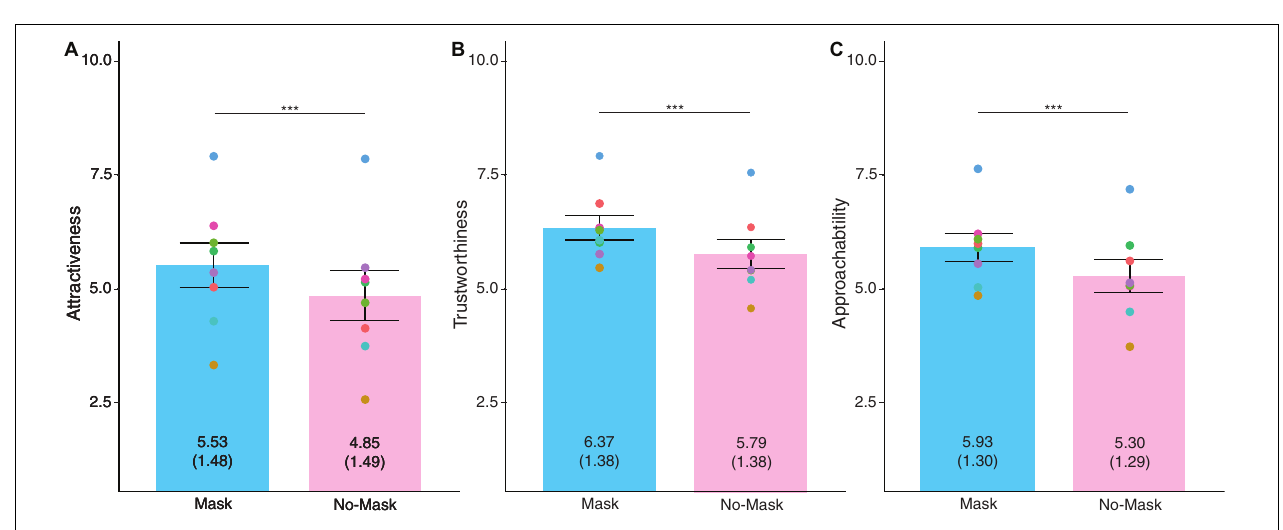
FIGURE 3 | Ratings for trait-like characteristics of (A) Attractiveness, (B) Trustworthiness, and (C) Approachability. Individual points represent averaged rating for each face. The values depicted in each bar are the mean ratings and the standard deviation is in parenthesis. Error bars indicate standard error means (SEM). Higher ratings indicate greater agreement to the perceived traits. *** p > 0.001, ** p > 0.01, * p > 0.05.